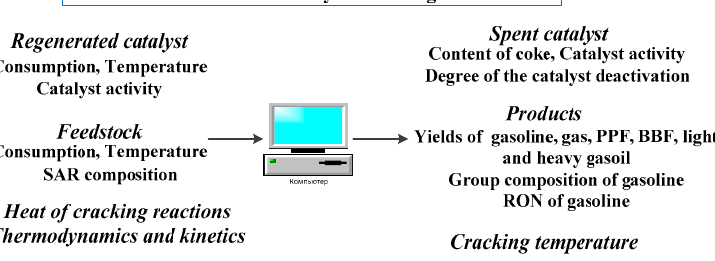
Figure 8. The major operating variables of catalytic cracking and prediction ability of the model.